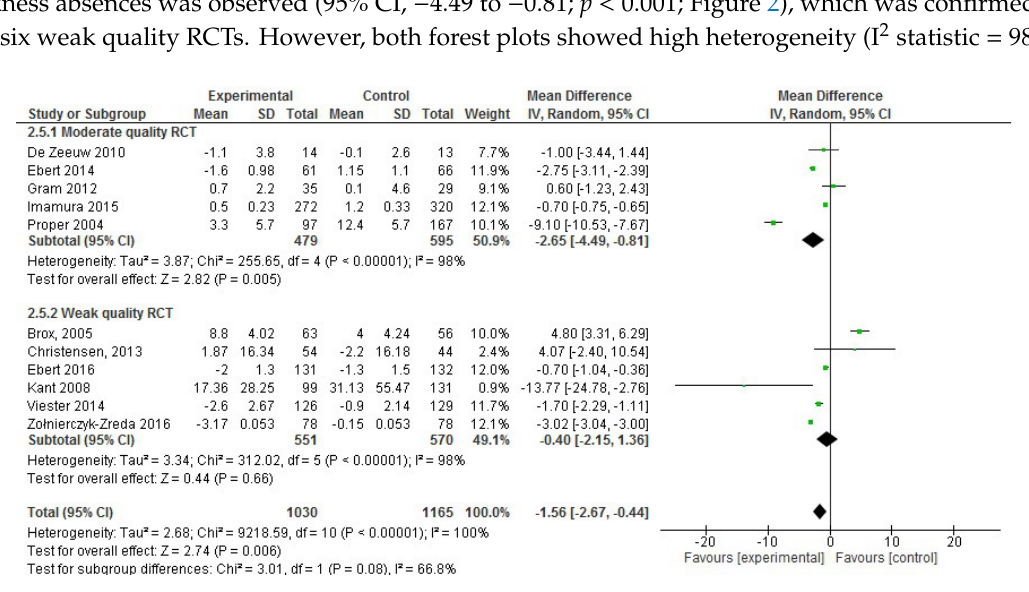
Figure 2. Forest plot of the effectiveness of workplace interventions for absenteeism reduction according to the quality of the studies.